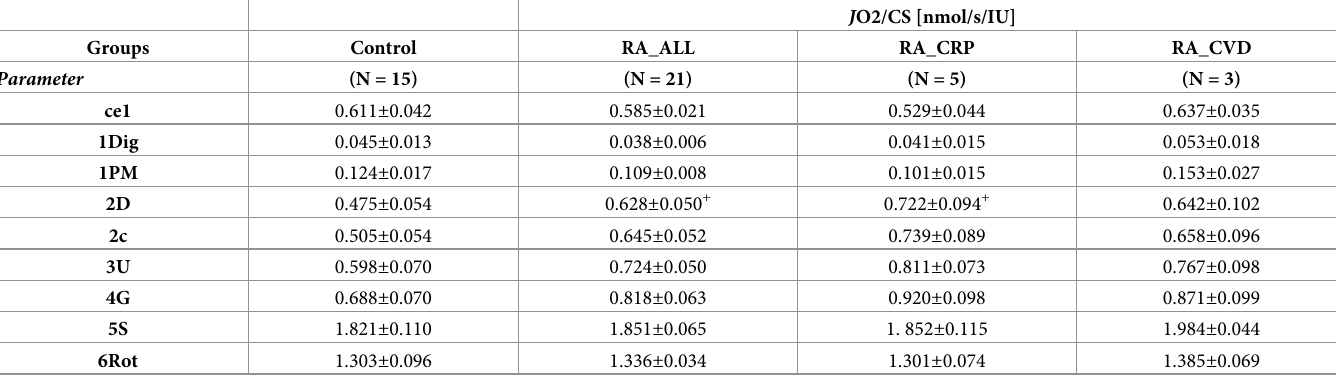
Table 2. Platelet mitochondrial function in control subjects and groups of RA patients.